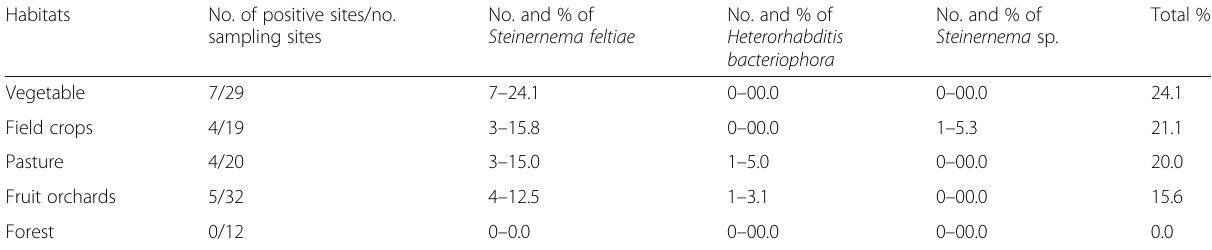
Table 1 Habitat types and percentage of sites in which entomopathogenic nematode isolates were recovered at Nevsehir in 2015 and 2016